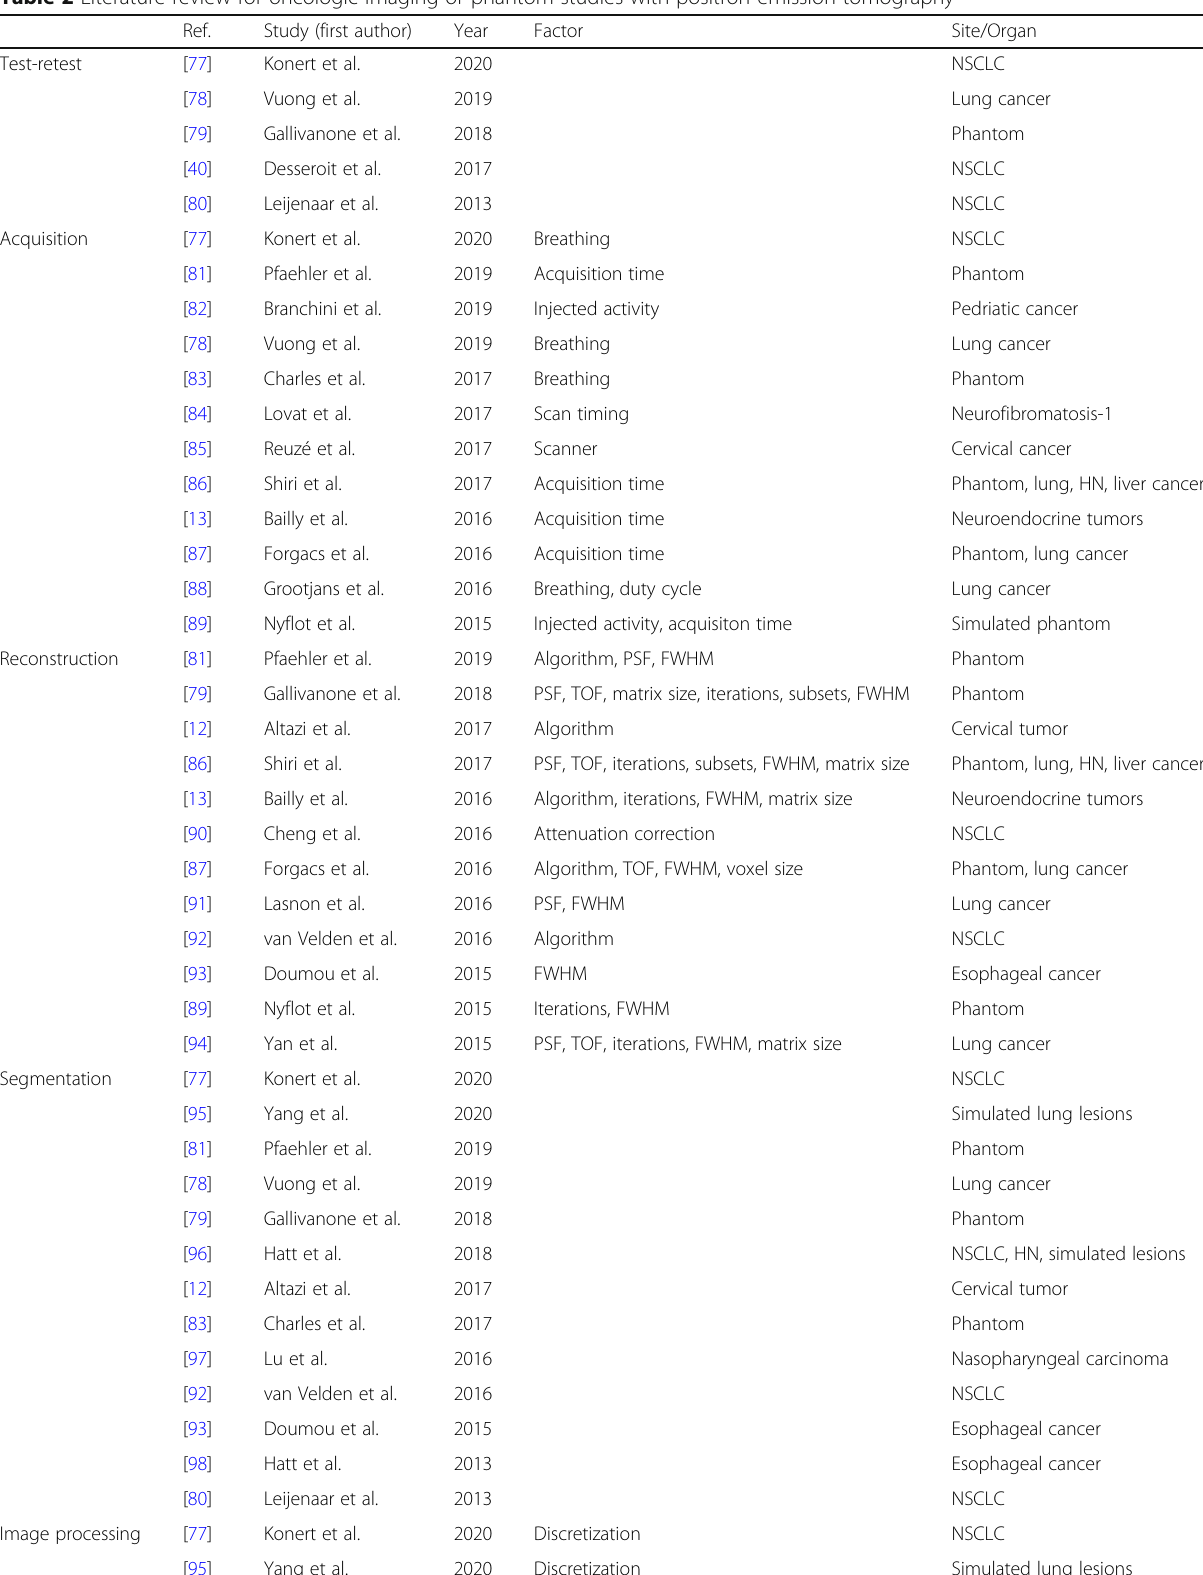
Table 2 Literature review for oncologic imaging or phantom studies with positron emission tomography